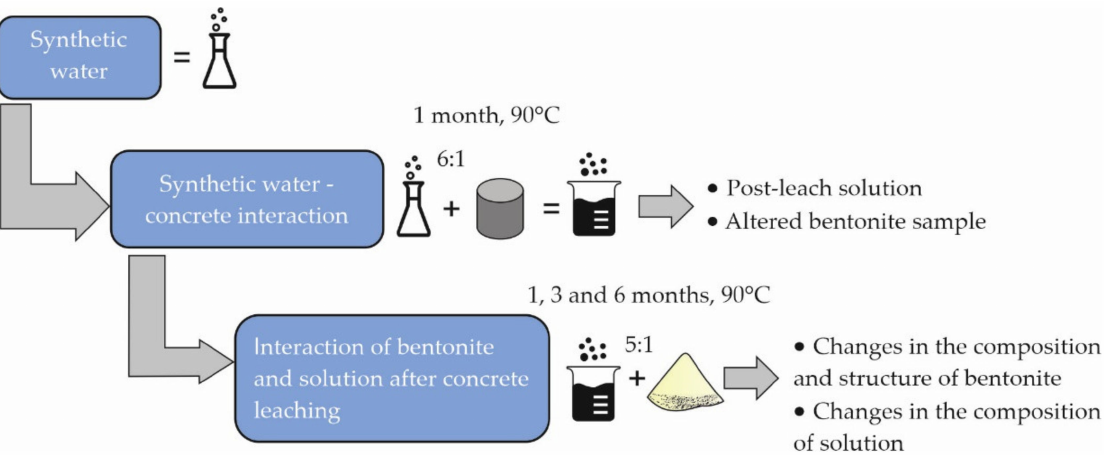
Figure 1. Schematic representation of the stages of the